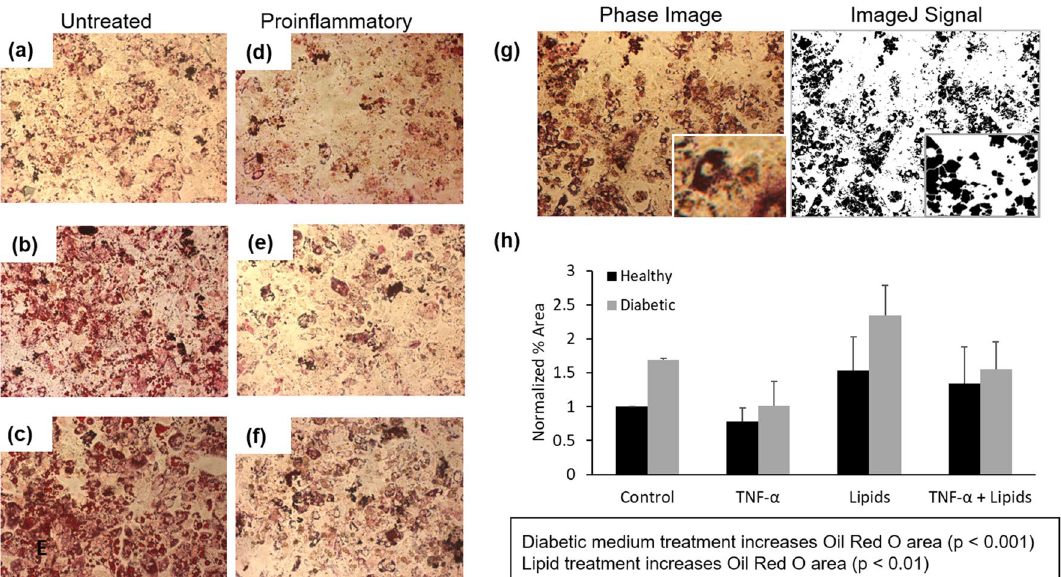
Figure 1. Characterization of hepatocytes in monoculture. Oil Red O staining showing lipid accumulation of hepatocytes after 14 days in ( a ) Healthy BMM ( b ) Diabetic BMM ( c ) Diabetic + obese BMM ( d ) Proinflammatory BMM ( e ) Diabetic + proinflammatory BMM ( f ) Diabetic, obese + proinflammatory BMM). ( g ) Comparison of ORO stained phase image and isolated signal used for quantification. ( h ) Quantification of overall lipid storage using ImageJ analysis. Statistical analysis performed as multi-way ANOVA followed by Dunnett’s test (α = 0.05) using the coverslip-wide average of two independent coverslips per condition.